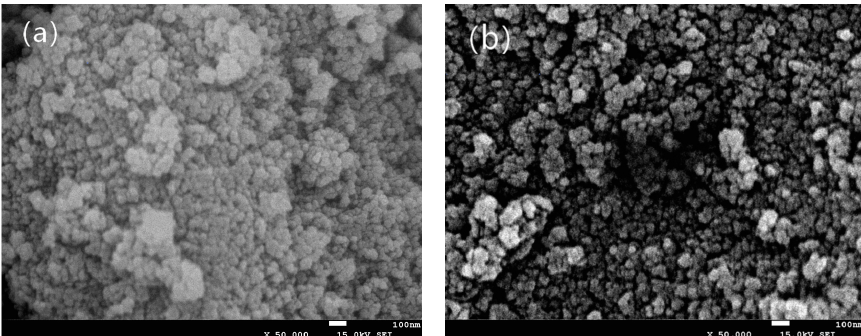
Figure 2. Scanning electron microscopy (SEM) images of TiO 2 nanoparticles ( a ) and modified TiO 2 nanoparticles ( b ).